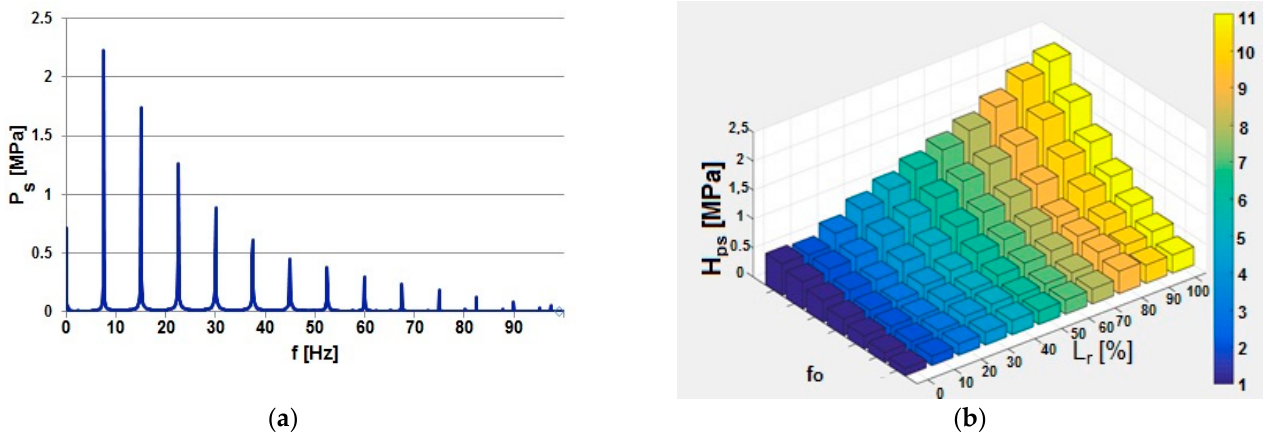
Figure 10. The spectrum of pressure in cylinder self ‐ ignition engines in the frequency band 0–100 Hz ( a ) and the 3 ‐ D effect of the load on the value of the amplitudes of harmonics in the spectrum of in ‐ cylinder pressures of a combustion engine ( b ).